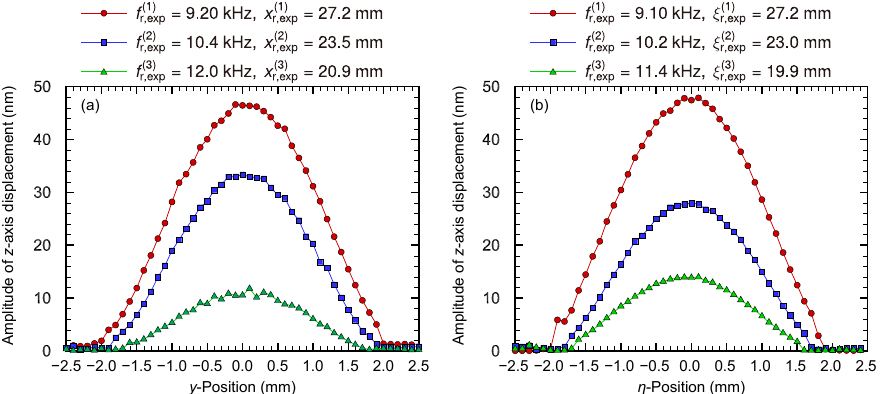
Figure 5. Experimentally obtained relationship between the oscillation amplitude and y -position of ( a ) the trapezoidal or ( b ) curved membrane device, where the oscillation is induced with each resonance frequency at the resonance y -positions. The amplitude distribution is symmetrical at y = η = 0 mm, and the amplitude is maximum at y = η = 0 mm. Furthermore, the amplitude and slope are zero near the fixed boundary. Thus, the amplitude distribution shows a fundamental oscillation mode for the y and η axes under the fixed-at-both-ends condition of the Euler–Bernoulli theory. The amplitudes were maximum on the x - or ξ -axis, i.e., y = η = 0, indicating that the symmetry was the same as in the numerical analysis. Furthermore, the amplitude and gradient were zero near the fixed boundary, and the experimental devices maintained the fixed boundary condition. Thus, the amplitude distribution demonstrated a fundamental oscillation mode under the fixed-at-both-ends condition of the Euler–Bernoulli theory for the y - or η -axis. The fundamental oscillation mode for the y direction has been observed in the previous studies [10,17], and it may be suggested that the y - or η -axis oscillation mode is dominant in the aspect ratio of the trapezoidal membrane device. Therefore, the oscillation on the x - or ξ -axis was measured for various x - or ξ positions and input frequencies, as shown in Figures 6 and 7,